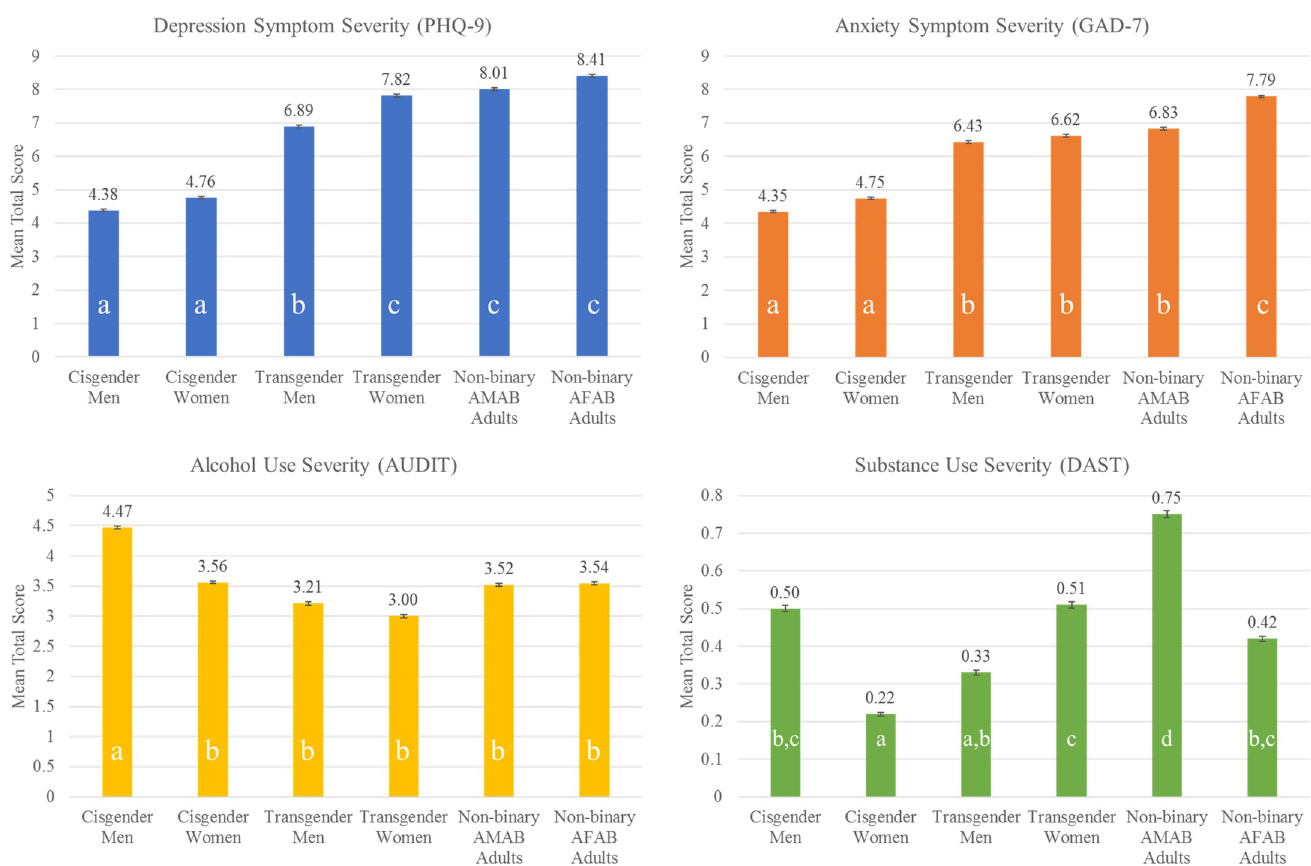
Fig 1. Mental health and substance use behavior severity among the gender categories. AMAB = Assigned Male at Birth; AFAB = Assigned Female at Birth. Letters embedded in each bar denote homogeneous groups (i.e. means of subgroups that have the same superscript do not significantly differ from each other) based on Tukey’s Honestly Significant Difference test significance at the p < .05